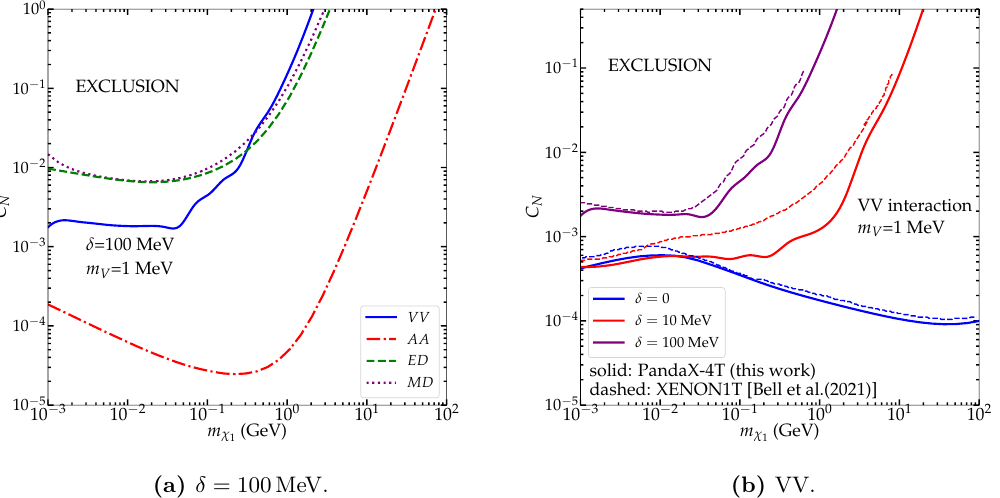
Figure 10. 95% upper limits projected in the ( m χ , C N ) plane. (a) the limits with fixed values δ = 100 MeV and m V = 1 MeV for VV, AA, ED, and MD. (b) Comparison between XENON1T